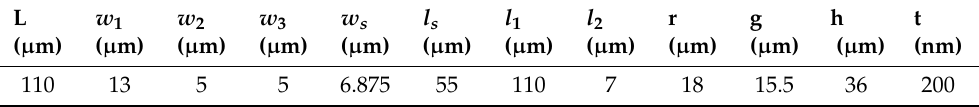
Table 4. Designed Parameters of the Proposed Triple Broadband Polarisation